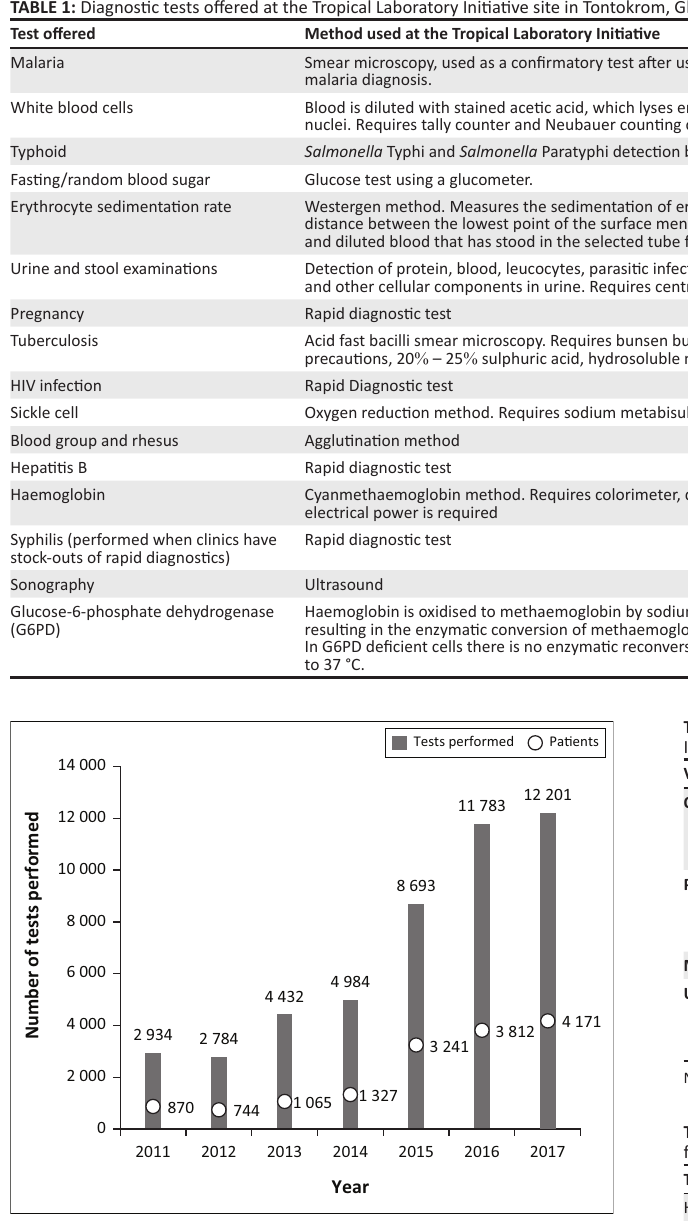
FIGURE 2: Tests performed at the Tropical Laboratory Initiative by year.